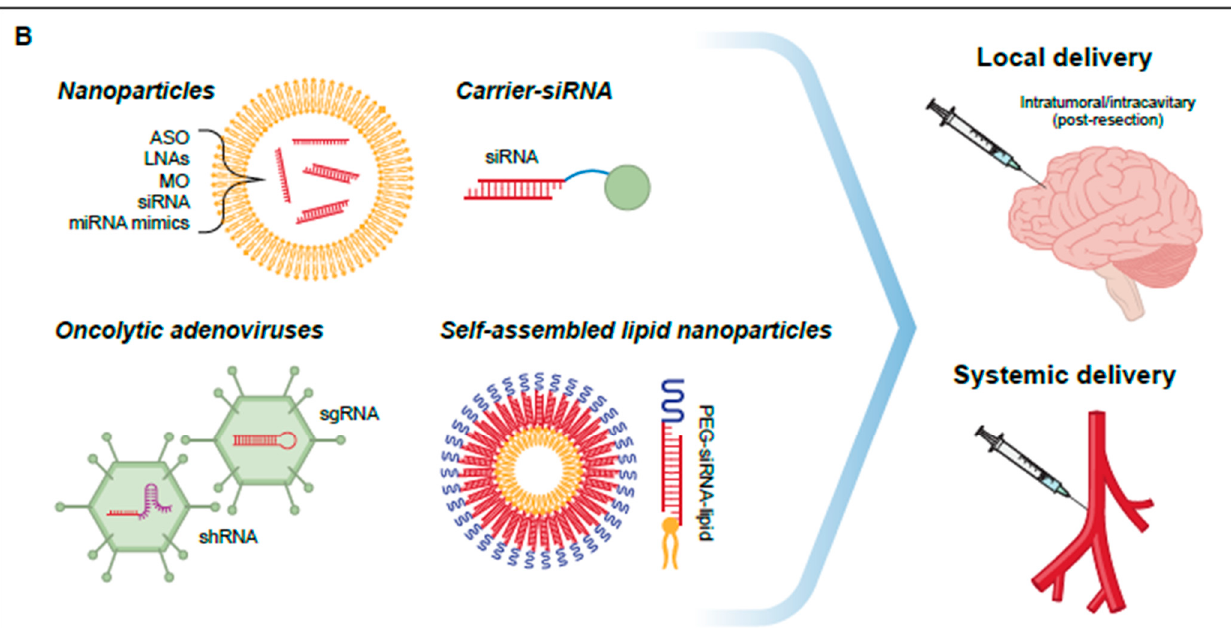
Figure 5. Therapeutic targeting of NcRNAs. ( A ) Schematic of the three common methods used to target ncRNAs. i. Nucleotide-based molecules, such as antisense oligonucleotides (ASOs), locked nucleic acids (LNAs), and morpholino oligonucleotides (MO) bind to their targeted RNA and use endogenous RNase H1 to promote RNA cleavage. ii. RNA interference (RNAi) involves the use of short interfering RNAs (siRNAs) and short hairpin RNAs (shRNAs) and utilizes the RNAi-induced silencing complex (RISC) to specifically degrade the targeted RNA. iii. CRISPR-Cas9 editing makes alterations at the genomic level by using a target specific single-guide RNA (sgRNA) and the Cas9 nuclease that specifically cleaves the genomic locus. ( B ) There are two possible delivery methods to deliver the ncRNA therapeutics: either local delivery within the tumour, or systemic. However, one of the main challenges with systemic delivery is overcoming the blood–brain barrier. To enhance their delivery, nucleotide-based therapeutics and siRNAs can be encapsulated inside nanoparticles. SiRNAs can also be delivered by chemically conjugating with carrier molecules, or through self-assembled lipid nanoparticles that are modified with PEG. ShRNAs and sgRNAs can be delivered by utilizing oncolytic adenoviruses.